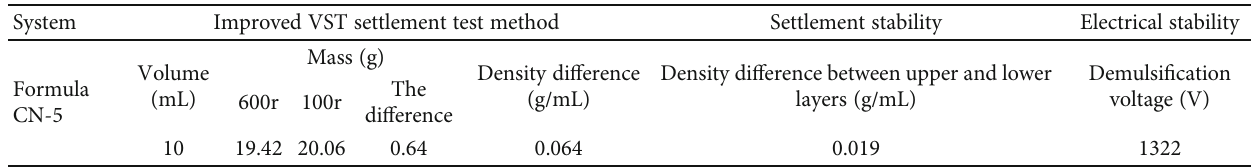
Table 10: Stability evaluation results of strong plugging drilling fl